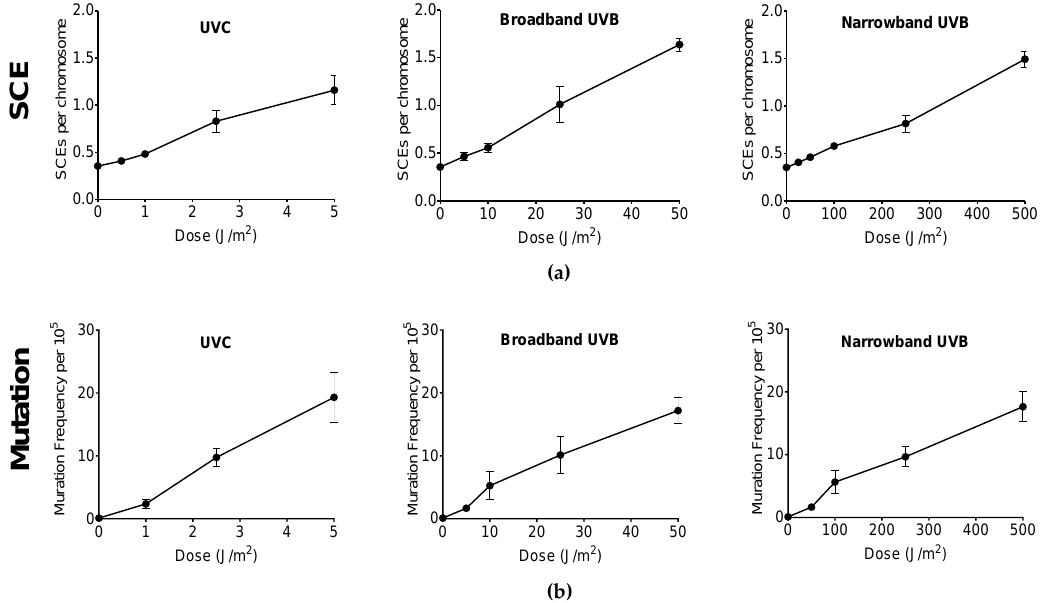
Figure 4. Genotoxicity and mutagenicity following UV exposure in CHO10B2 cells. ( a ) Sister chromatid exchange (SCE) frequency following UVC, BB-UVB, and NB-UVB at increasing dosage. ( b ) Hypoxanthine phosphoribosyltransferase ( HPRT ) mutation frequency following UVC, BB-UVB, and NB-UVB at increasing dosage. Error bars indicate standard errors of the means from at least three independent experiments.